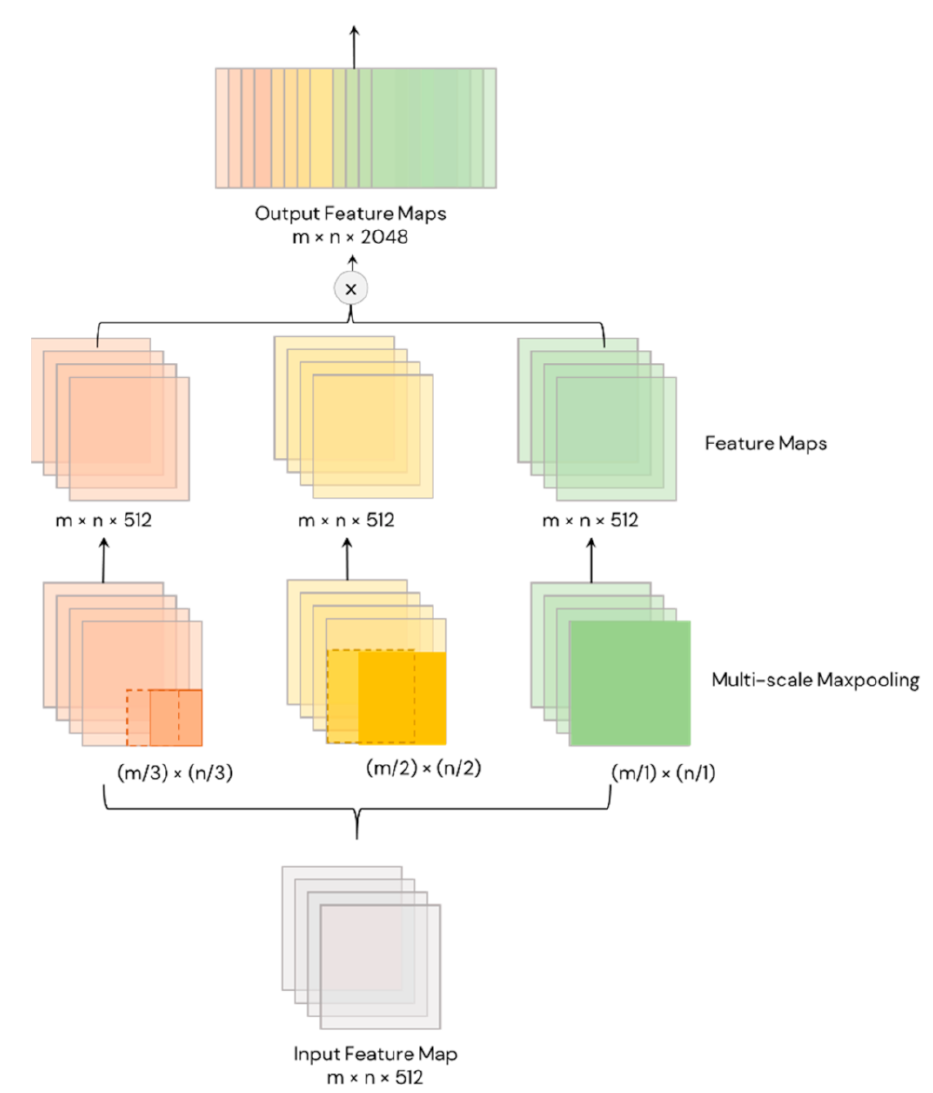
Figure 8. Spatial Pyramid Pooling in